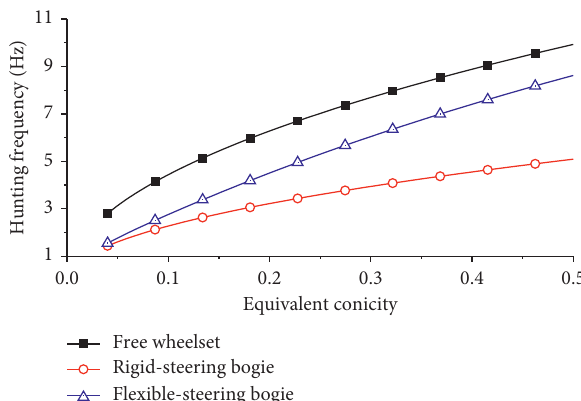
Figure 6: Hunting frequency of a free wheelset and rigid- and flexible-steering bogie.